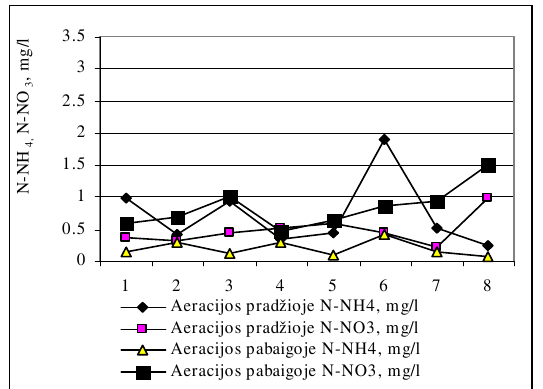
Fig 6. Concentration change of ammonium nitrogen and nitrates in the second aeration tank in the beginning and at the end of aeration at aeration rate of 180 min, and redu- ced aeration rate of 150